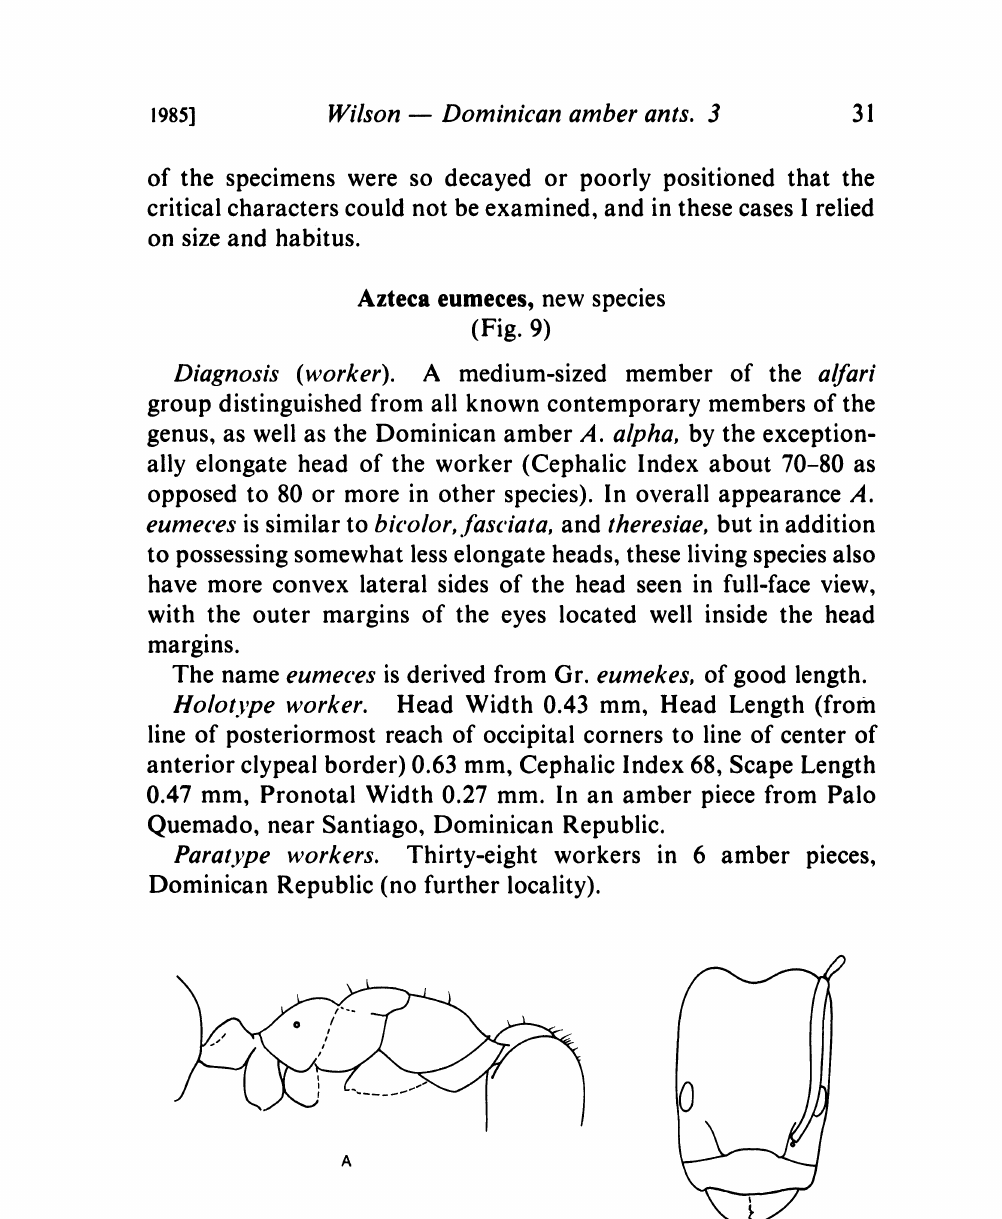
Fig. 9. A.zteca eumeces holotype worker: A, side view of body; B,